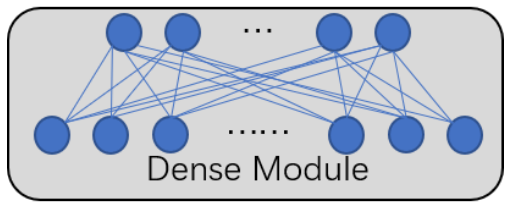
Figure 4. The framework of the Dense